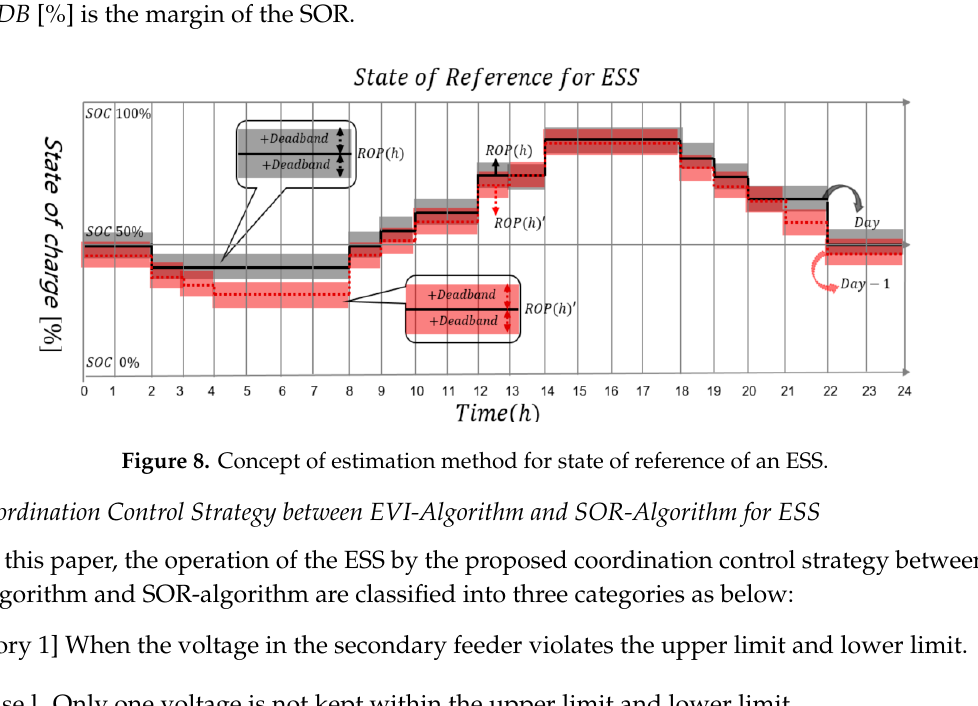
Figure 9. Energies 2020 , 13 , 179